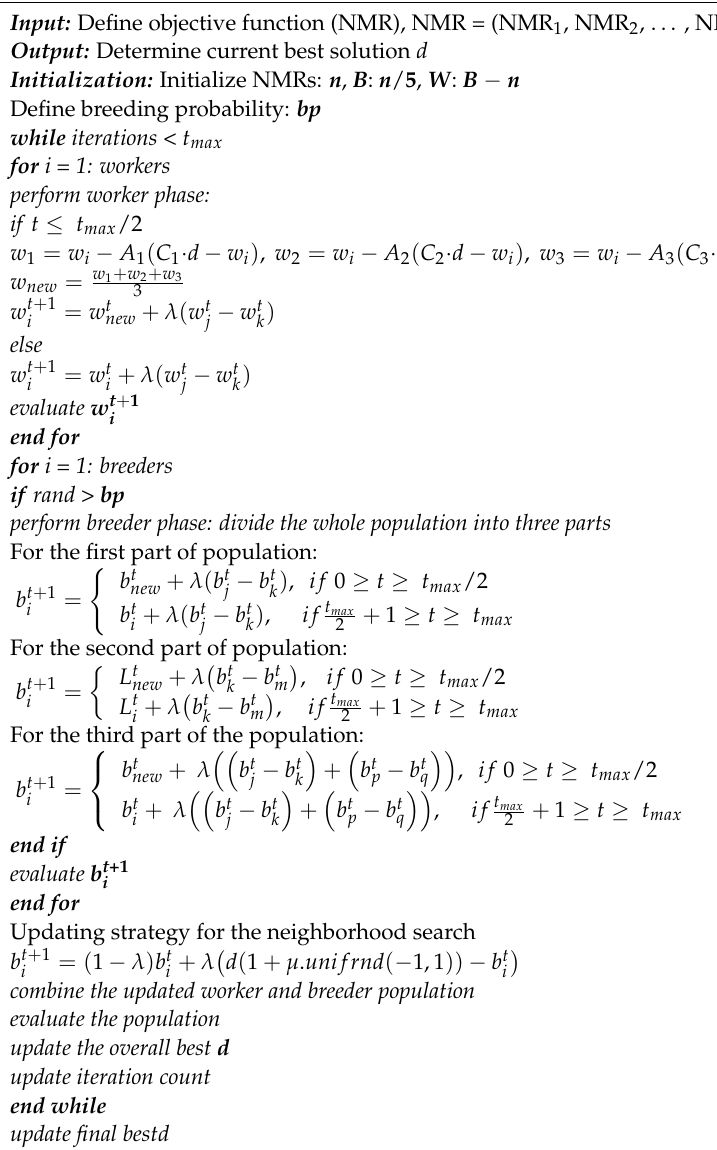
Algorithm 2. Pseudocode of Enhanced